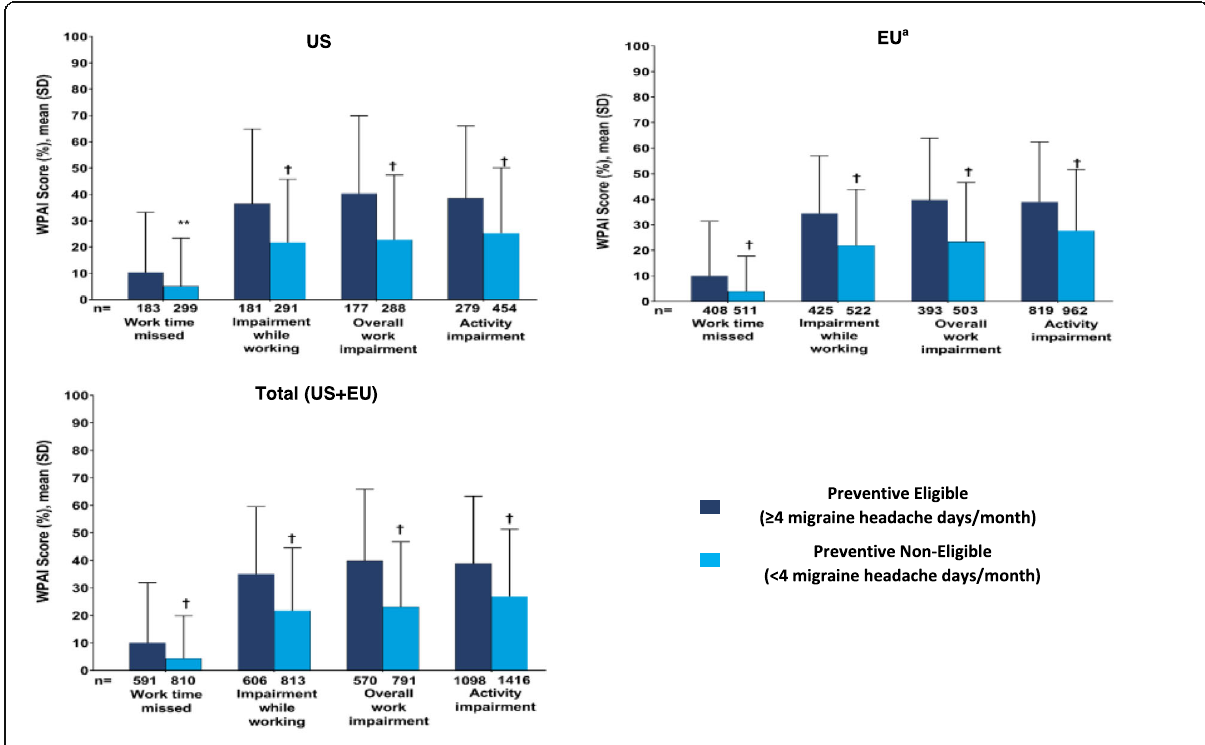
Fig. 5 WPAI score (%) in patients with migraine by preventive treatment eligibility